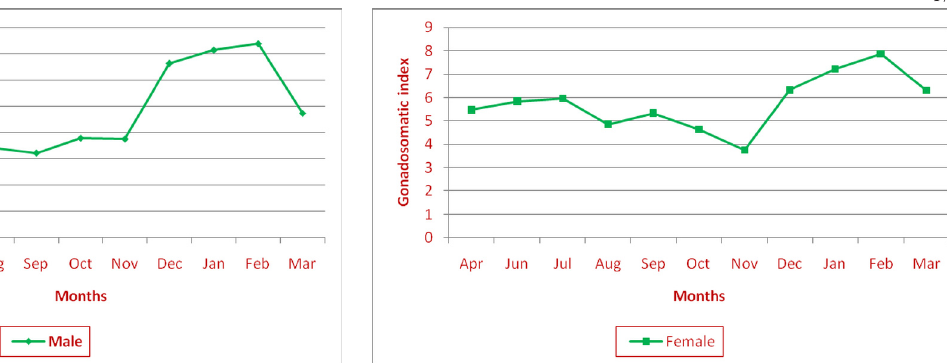
Fig. 5. Monthly variation in mean GSI for male S . lessoniana Fig. 6. Monthly variation in mean GSI for female S. lessoniana